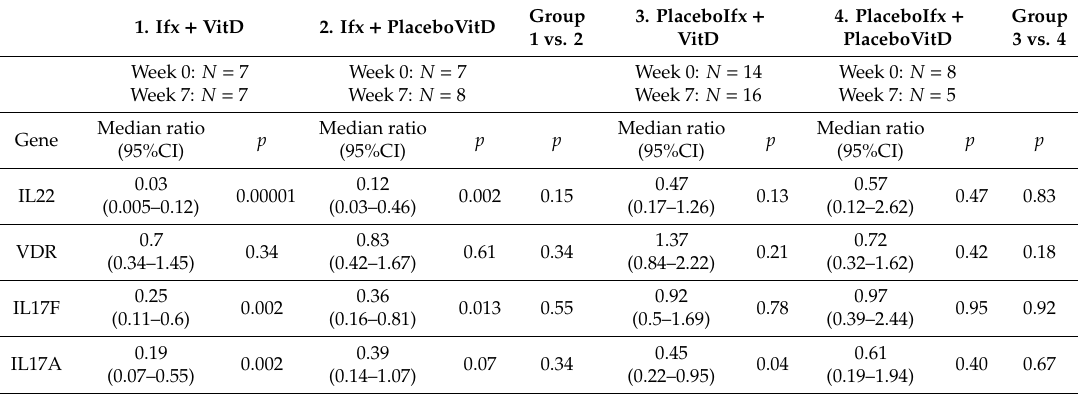
Table 2. Changes in mucosal mRNA expression of IL22, vitamin D receptor (VDR), IL17F and